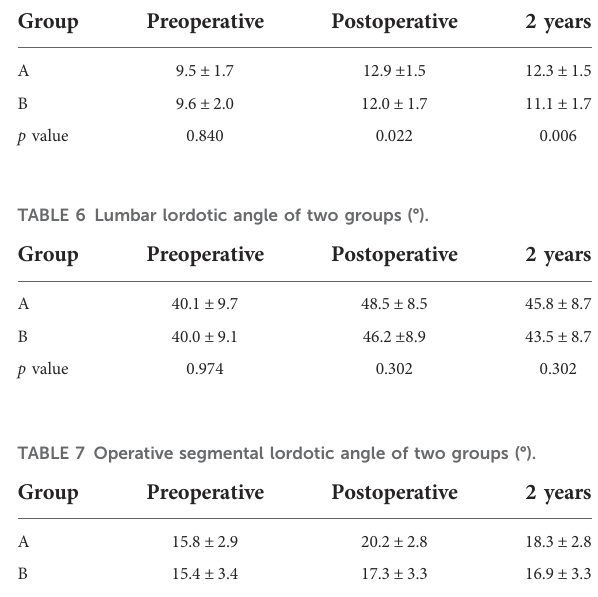
TABLE 5 Intervertebral space height of two groups (mm).